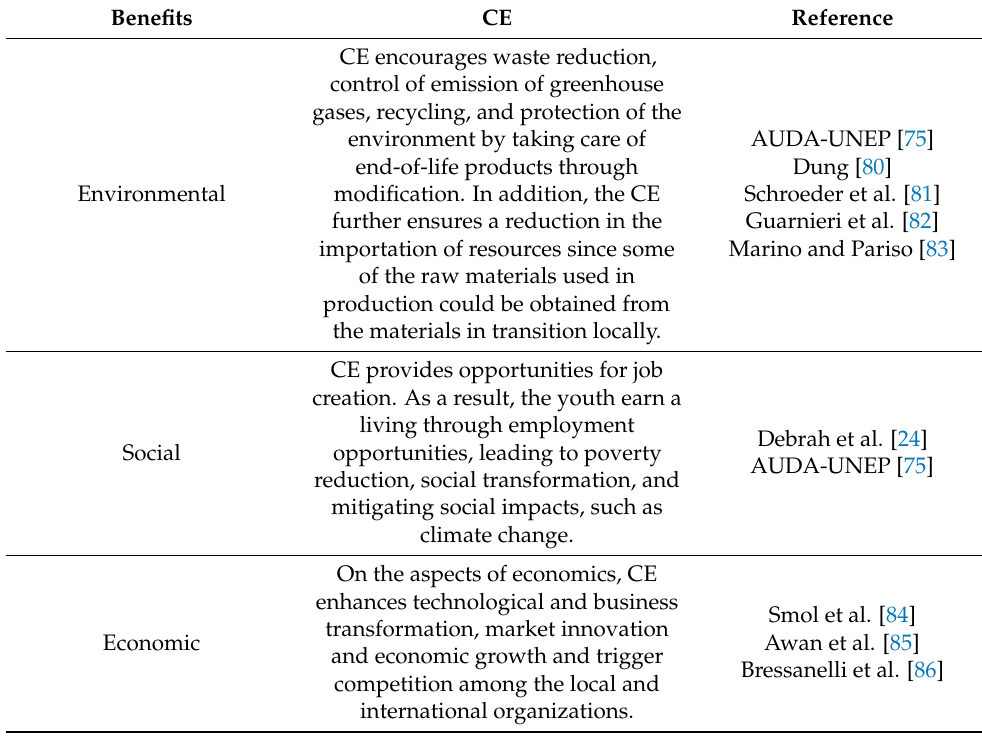
Table 1. Environmental, social and economic benefits derived from